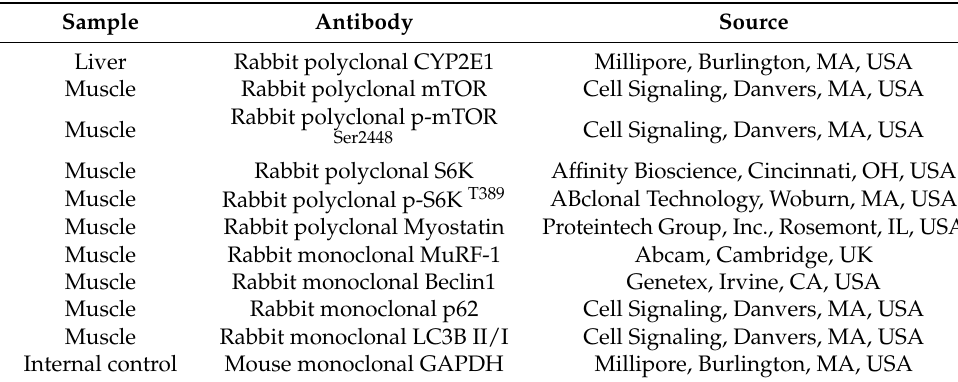
Table 8. List of antibodies for analyzing related proteins in this study.